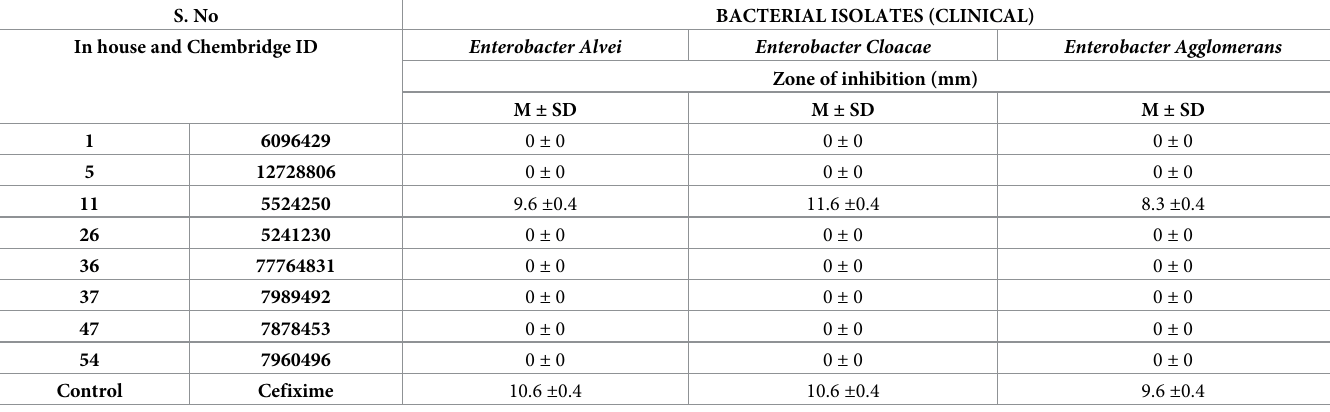
Table 2. Antibacterial activity of lead compounds against β -lactamase producer clinical bacterial isolates. S. No BACTERIAL ISOLATES